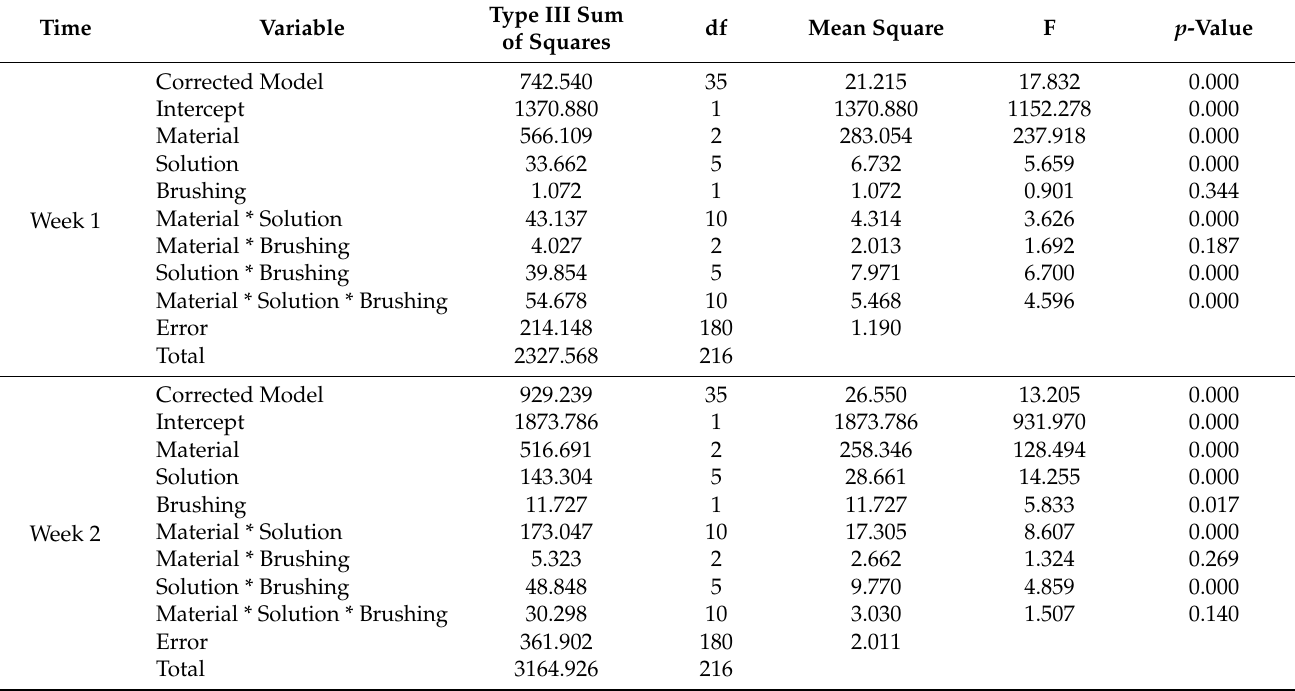
Table 5. Interaction among ∆ E values in the three-way analysis of